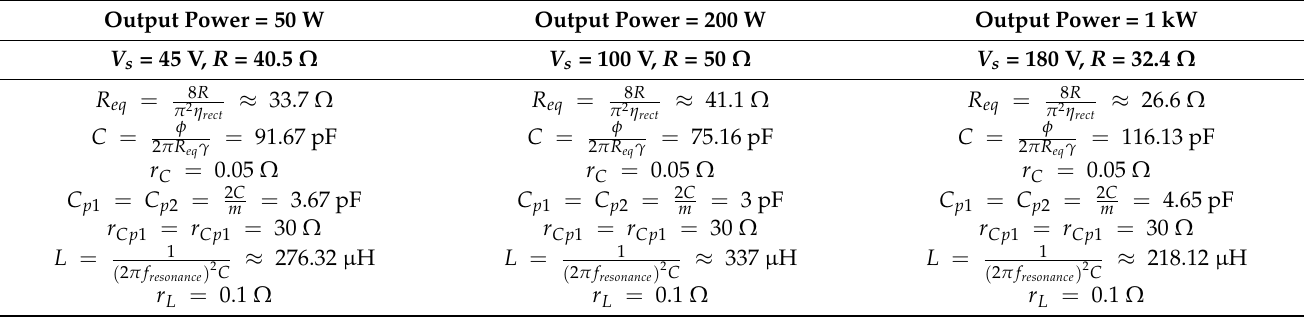
Table 2. Modified Z-tank values for output power 50 W, 200 W, and 1 kW, considering m = 50,